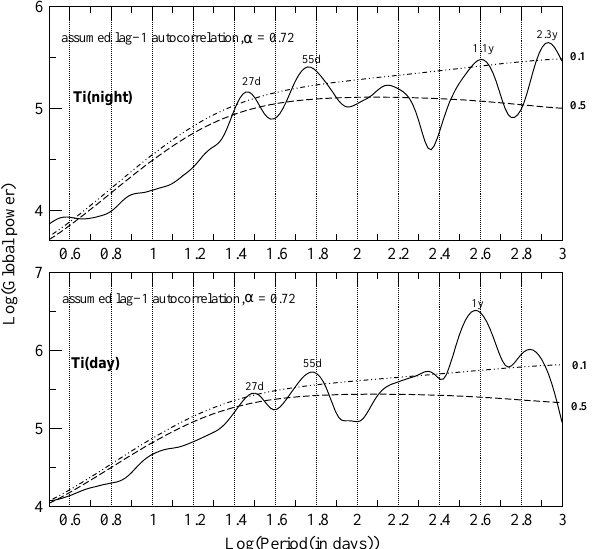
Fig. 10. Wavelet spectra of electron temperature during the night- time. Other details same as Fig.